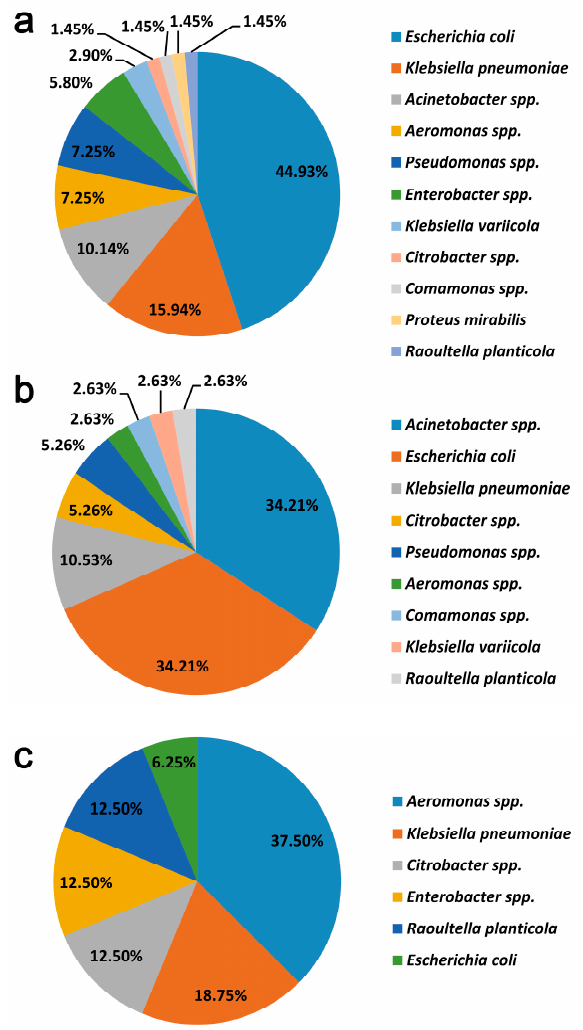
Figure 2. Distribution of the bla CTX-M ( a ), bla NDM ( b ), or bla KPC ( c ) in the collected isolates in this study.